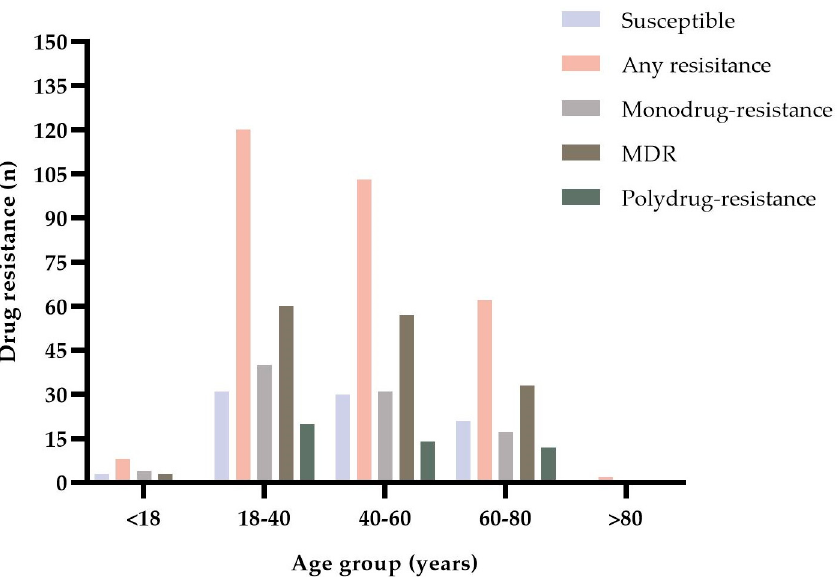
Figure 4. Number of 380 MTB-positive FFPE specimens by age group and drug resistance pattern.